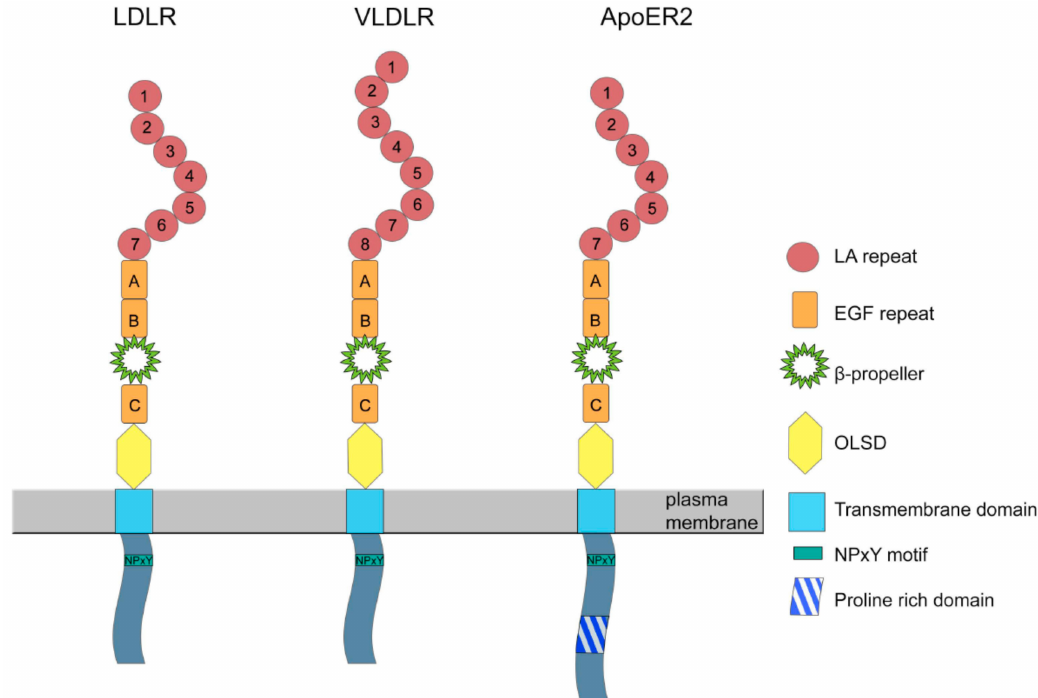
Figure 1. Structures of low density lipoprotein receptor (LDLR), VLDL receptor (VLDLR), and Apolipoprotein E receptor 2 (ApoER2). The LDL receptor and its closest relatives VLDL receptor and ApoER2 are composed of six characteristic superimposable structural modules: (1) ligand binding domain with a variable number of LDL receptor type A repeats (LA repeats), (2) epidermal growth factor precursor-like repeats A, B, and C (EGF repeats), (3) a YWTD containing domain forming a so-called β -propeller, (4) the O -linked sugar domain (OLSD), (5) a transmembrane domain, and (6) a cytoplasmic domain containing the NPXY motif and facultatively a proline-rich domain unique for ApoER2. Domains are not drawn to